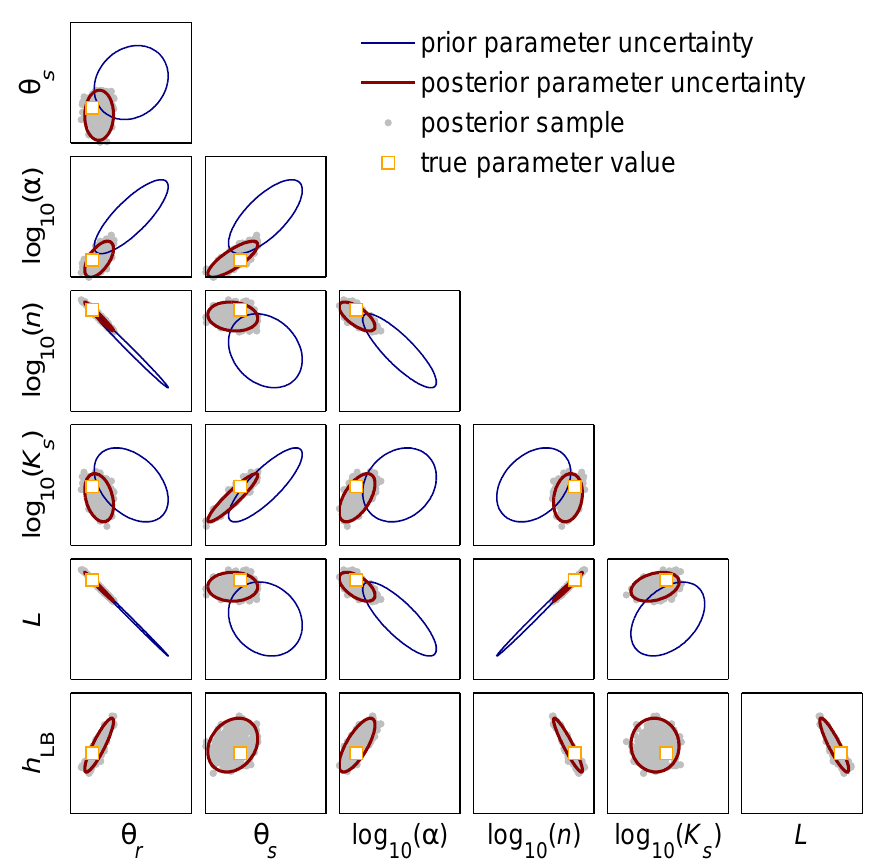
Fig. 5. Pairwise scatter plots of the posterior sample and corresponding 95% confidence ellipses using synthetic soil water content data and the biased prior probability distribution with correlation among the soil hydraulic parameters (Prior 3). The axes cover the bounds listed in Table